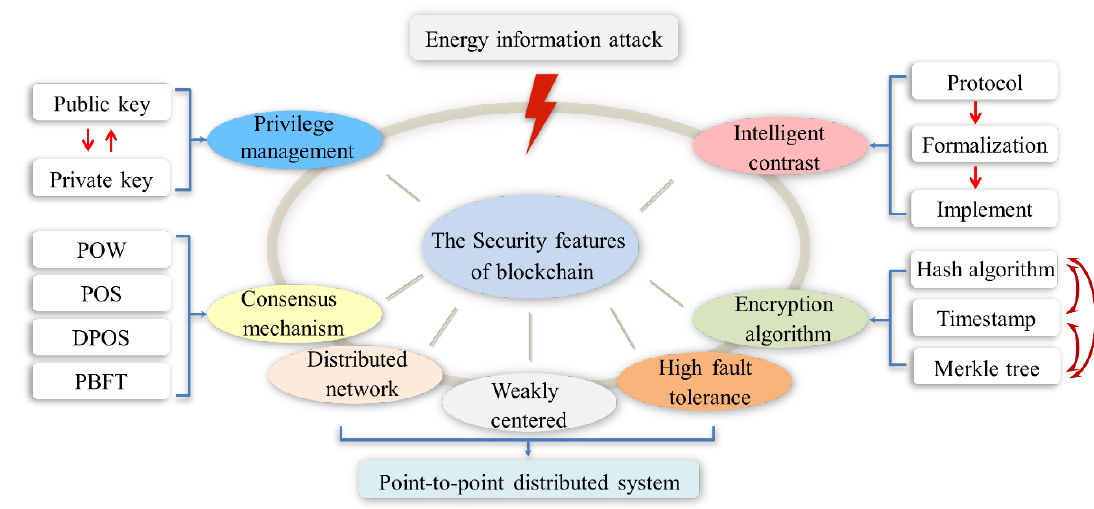
Figure 3. Security features of the blockchain technology.